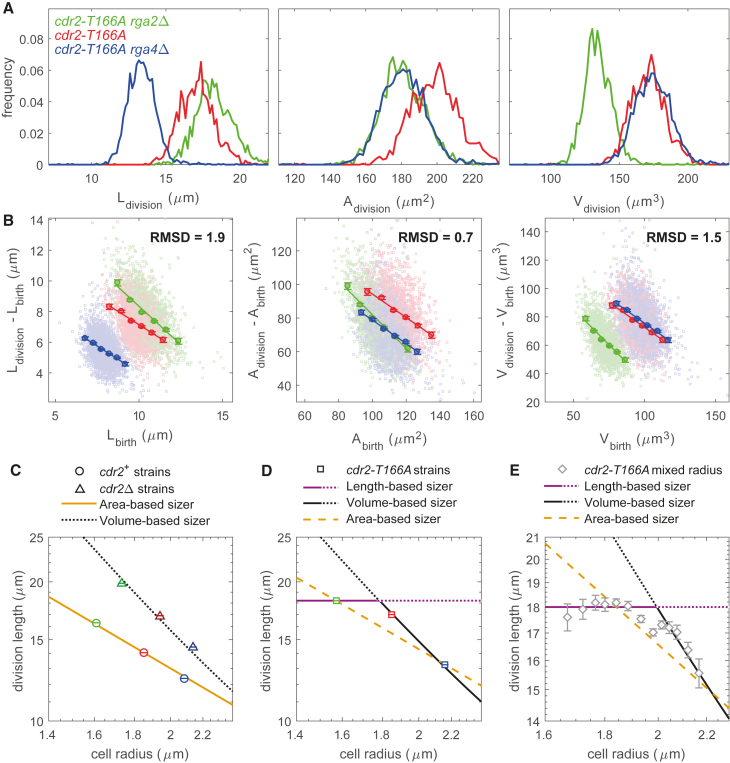
Size Homeostasis Is Based on Length in Thin cdr2-T166A Cells(A) Distribution of cell length, surface area, and volume at division for cdr2-T166A rga2Δ, cdr2-T166A, and cdr2-T166A rga4Δ.(B) Size homeostasis plots for cdr2-T166A rga2Δ, cdr2-T166A, and cdr2-T166A rga4Δ using cell length, surface area, or volume as size measure. Slopes are −0.9 (cdr2-T166A rga2Δ), −0.7 (cdr2-T166A), and −0.7 (cdr2-T166A rga4Δ). Color legend: cdr2-T166A rga2Δ (FC3218; green; n = 1,785), cdr2-T166A (FC3216; red; n = 1,561), and cdr2-T166A rga4Δ (FC3220; blue; n = 2,309). Binned data (with mean value ± SE) and associated regression line are shown in (B). Normalized RMSD (between binned data; STAR Methods) is also stated.(C) Relationship between division length and cell radius depends on the geometrical sensing: slope −1 for an area-based sizer mechanism (yellow full line; logLdiv=log(Adiv/2π)−logR, with Adiv=165μm2), slope of ≈ −2 for a volume-based sizer (black dotted line; logLdiv≈log(Vdiv/π)−2logR, with Vdiv=180μm3). Data from Figure 1 are reported as mean value ± SE (color legend: rga2Δ, green; wild-type, red; rga4Δ, blue). Fitting is obtained by changing the intercept only (specified by Adiv or Vdiv).(D) Data from (A), reported as mean value ± SE (cdr2-T166A strains; same color legend as in A), consistent with a length-based sizer for thin cells (purple full and dotted line) and volume-based sizer for fat cells (black full and dotted line). An area-based sizer (dashed yellow line) is less consistent with the data.(E) Experiment at higher pixel resolution on a mixture of cdr2-T166A rga2Δ, cdr2-T166A, and cdr2-T166A rga4Δ cells (total n = 401), using bin analysis based on cell radius (with mean value ± SE), demonstrating crossover from length-based sizer (purple full and dotted line) to volume-based sizer (black full and dotted line) behavior. A single area-based sizer (dashed yellow line) cannot fit the data (p value < 10−20 using χ2 test).See also Figure S4.